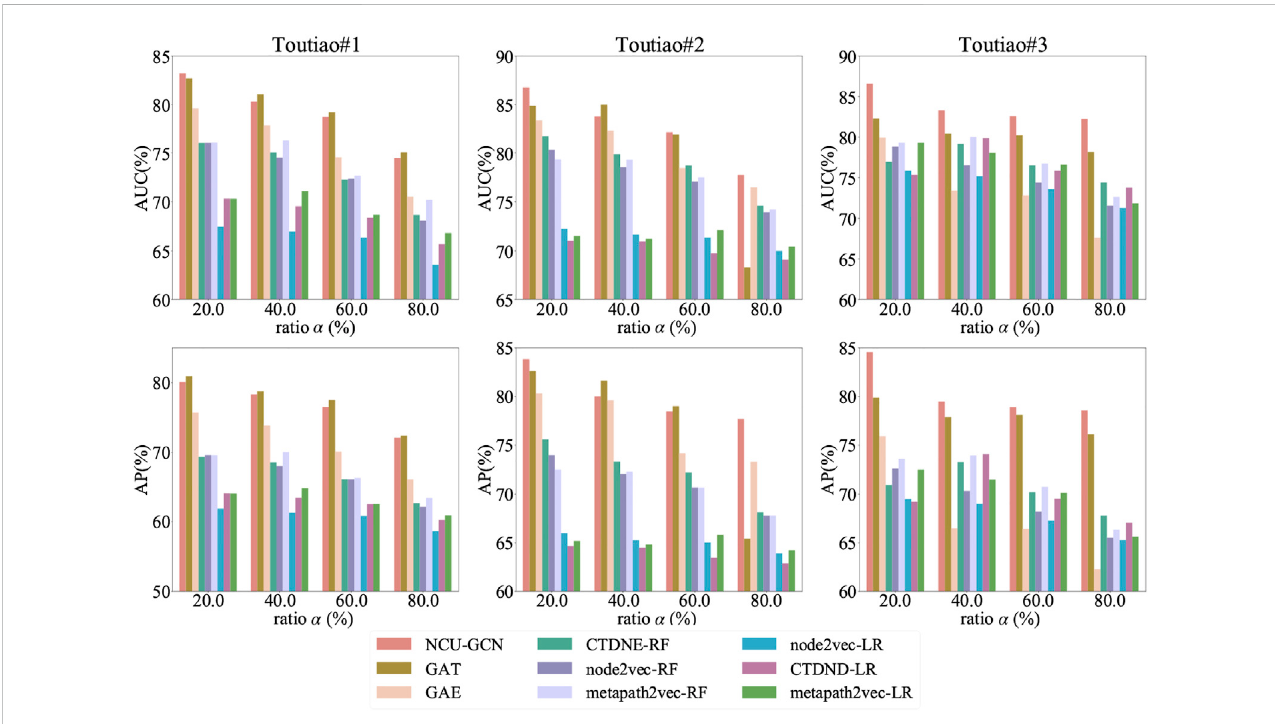
FIGURE 8 Performance of different methods on three different datasets when α